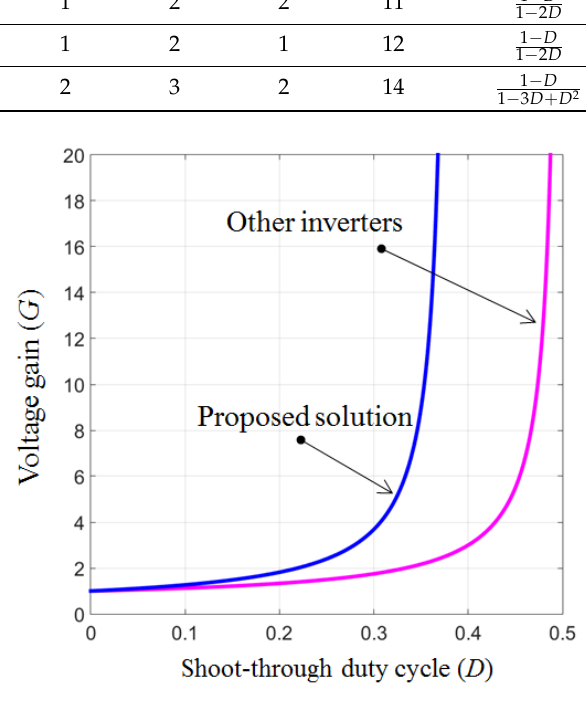
Figure 8. Voltage gain comparison.